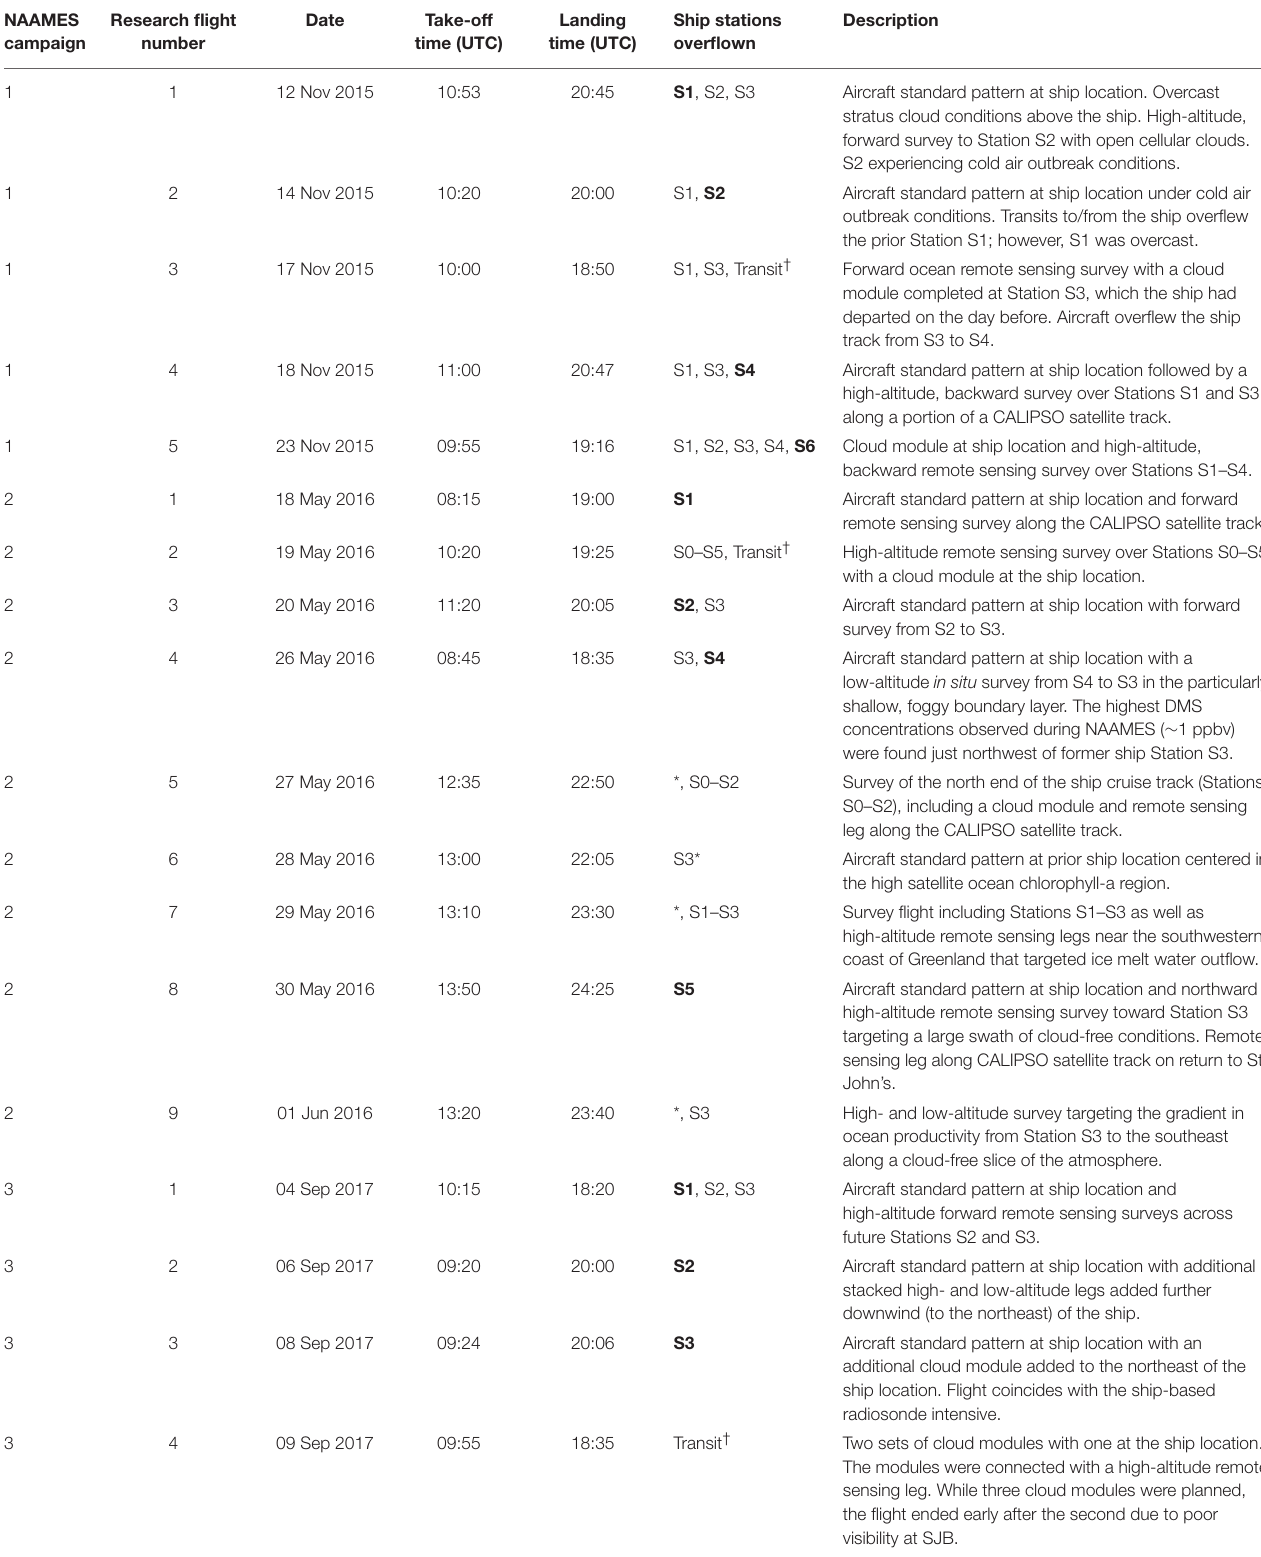
TABLE 2 | Summary of NAAMES aircraft